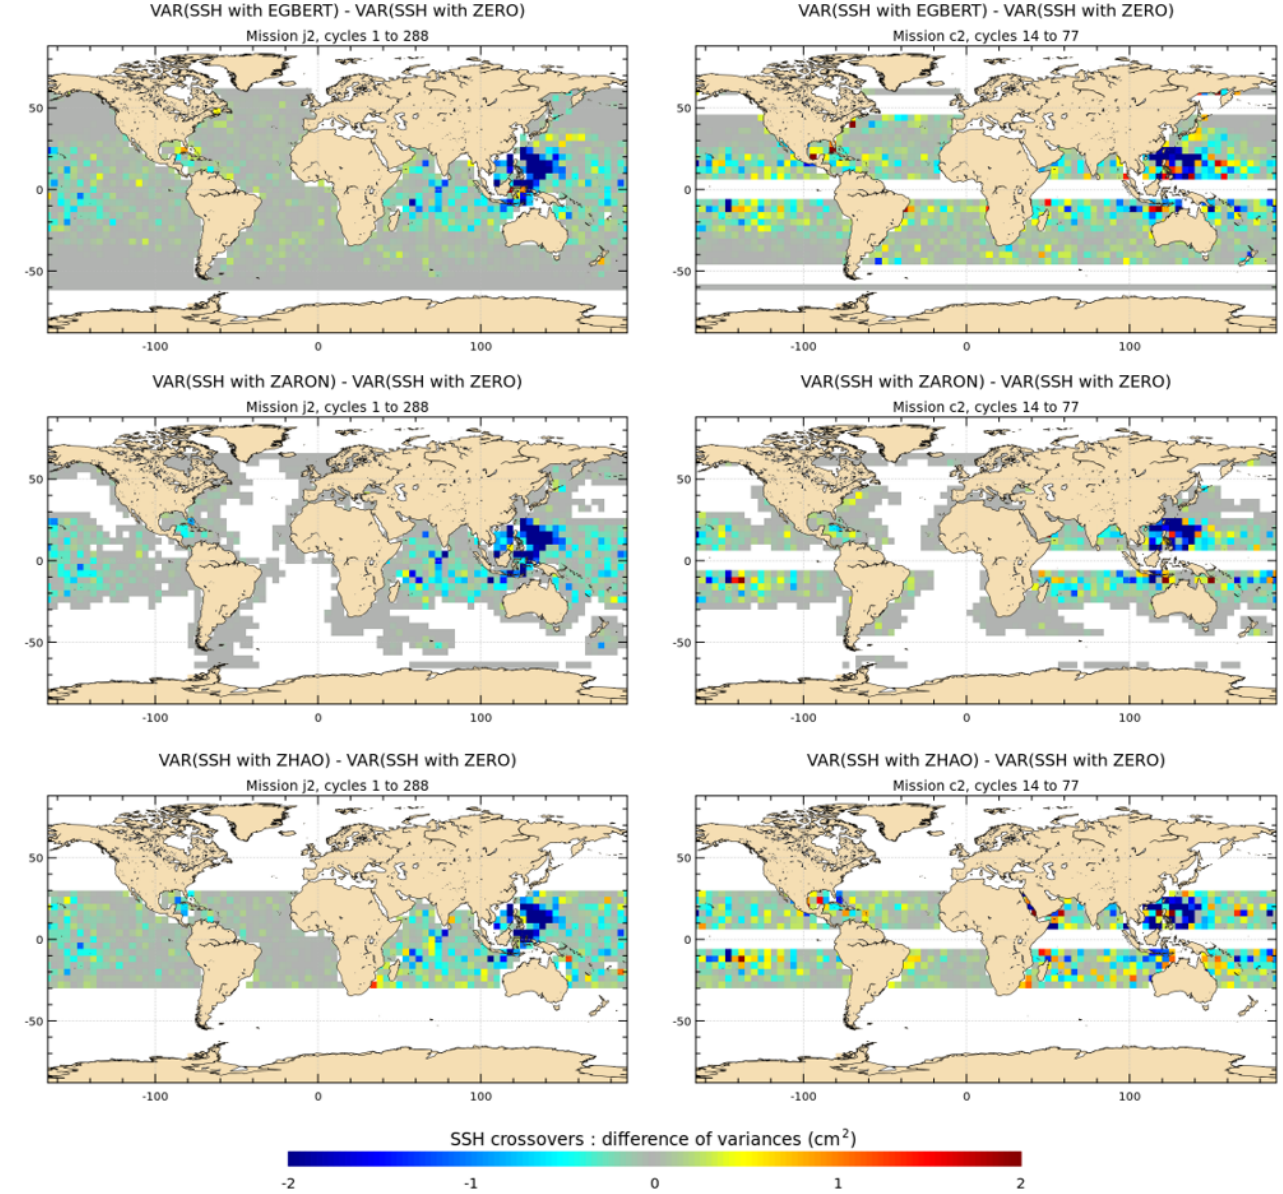
Figure 11. Maps of SSH variance differences at crossovers using either the K 1 IT correction from each model or a reference ZERO correction in the SSH calculation for the J2 and C2 missions (cm 2 ). J2 cycles 1–288 have been used; C2 cycles 14–77 have been